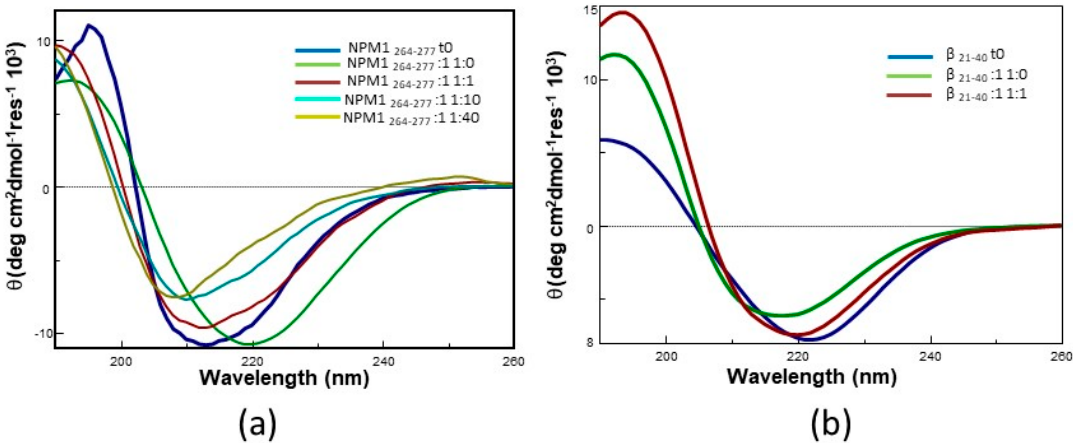
Figure 7. Overlay of CD spectra of ( a ) NPM1 264–277 and ( b ) A β 21–40 incubated under stirring with 1 at different peptide to Pt compound molar ratio. Incubation time: overnight.